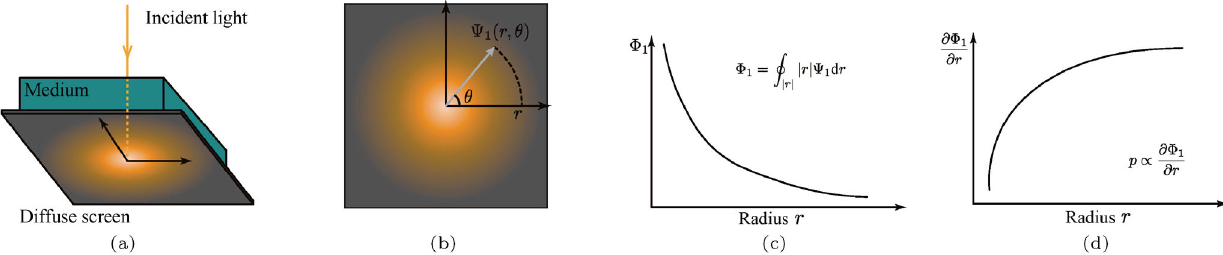
Fig. 4 Workflow for measuring the non-parametric phase function. Illustration of (a) observation from lower angle, (b) obtained scattering distribution, (c) Φ 1 , and (d) Ψ 1 which is proportional to the scattering function.